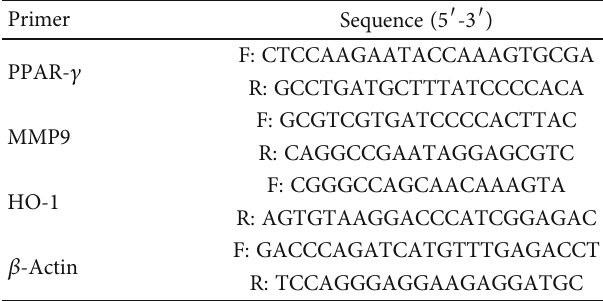
Table 1: The sequences of all